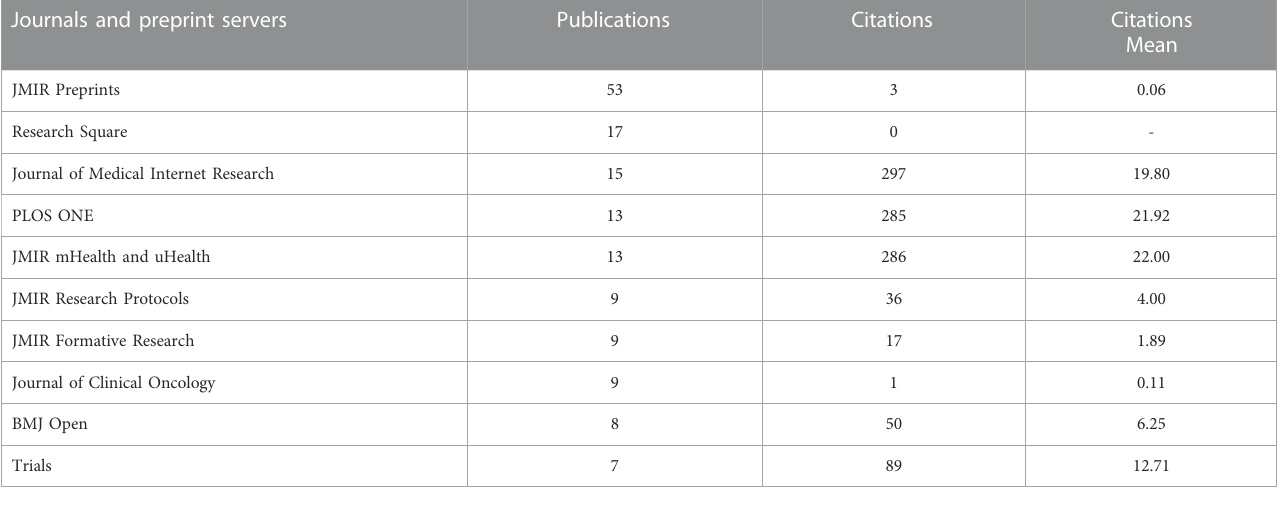
TABLE 4 Leading journals and preprint servers presenting publications in the fi eld of digital pills for the period January 2012 to July 2022.